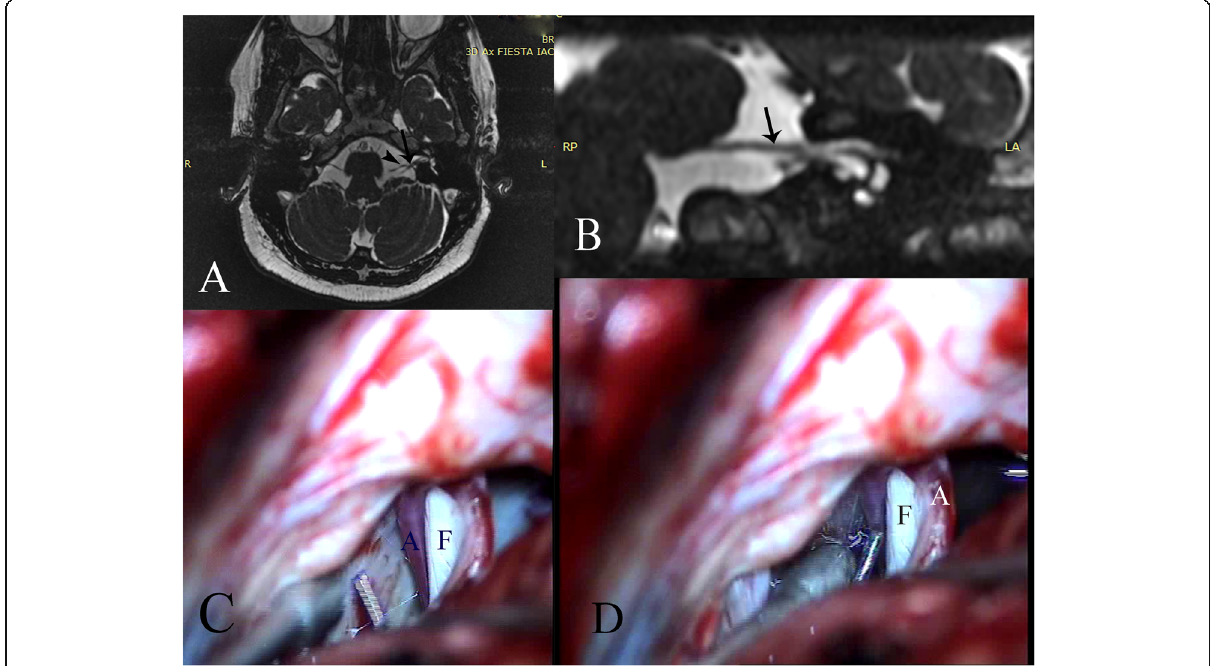
Fig. 3 a FIESTA showing vascular compression on the facial nerve (left side). Arrow points to the facial nerve, arrowhead points to the vascular loop. b Processed image where arrow points to the vascular loop. c , d Microscopic view showing the vascular loop compressing the facial nerve (left side) and is hidden under the suprameatal tubercle. F., facial nerve. A., AICA